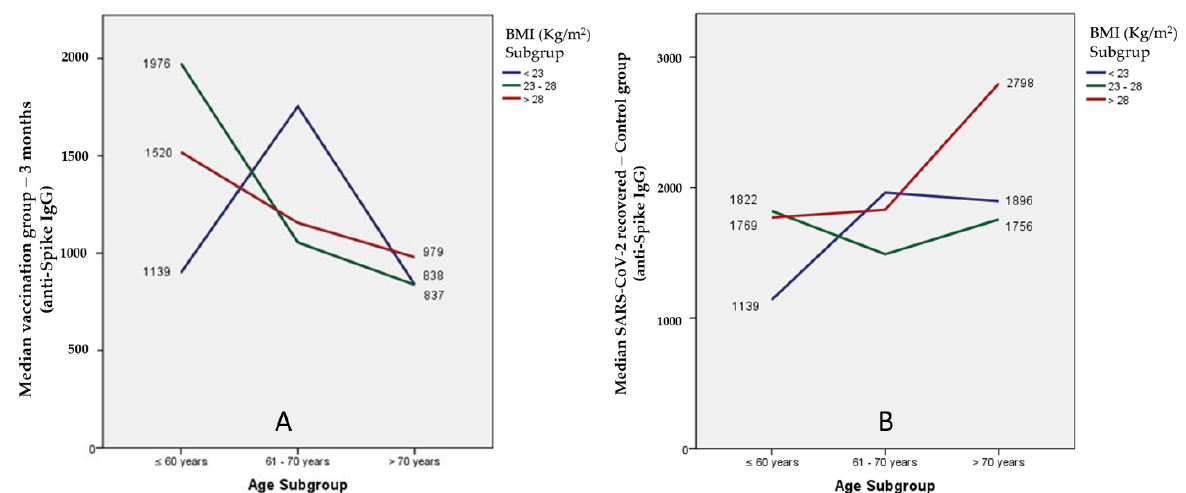
Figure 2. Graphic representation of anti-spike IgG antibodies level between weight and body mass index (BMI) variables in the vaccinated and control group. ( A ) In the vaccinated group, a greater variation of the humoral response was observed in the youngest and among the three sub-groups of the BMI variable. ( B ) There was a high humoral response in older (>70 years) and heavier (BMI > 28 kg/m 2 ) patients in the control group.